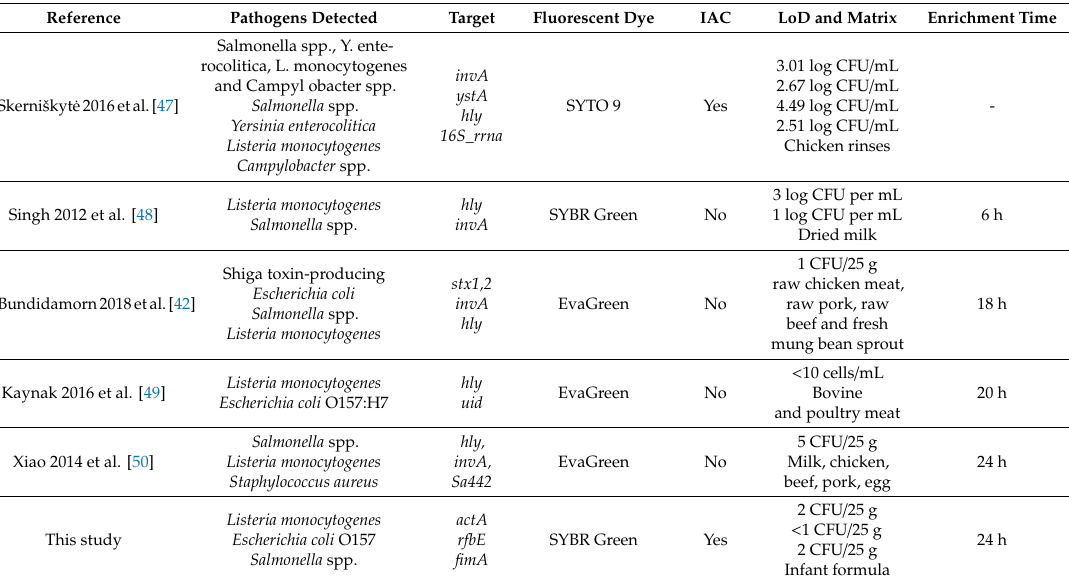
Table 7. Comparison of previously published